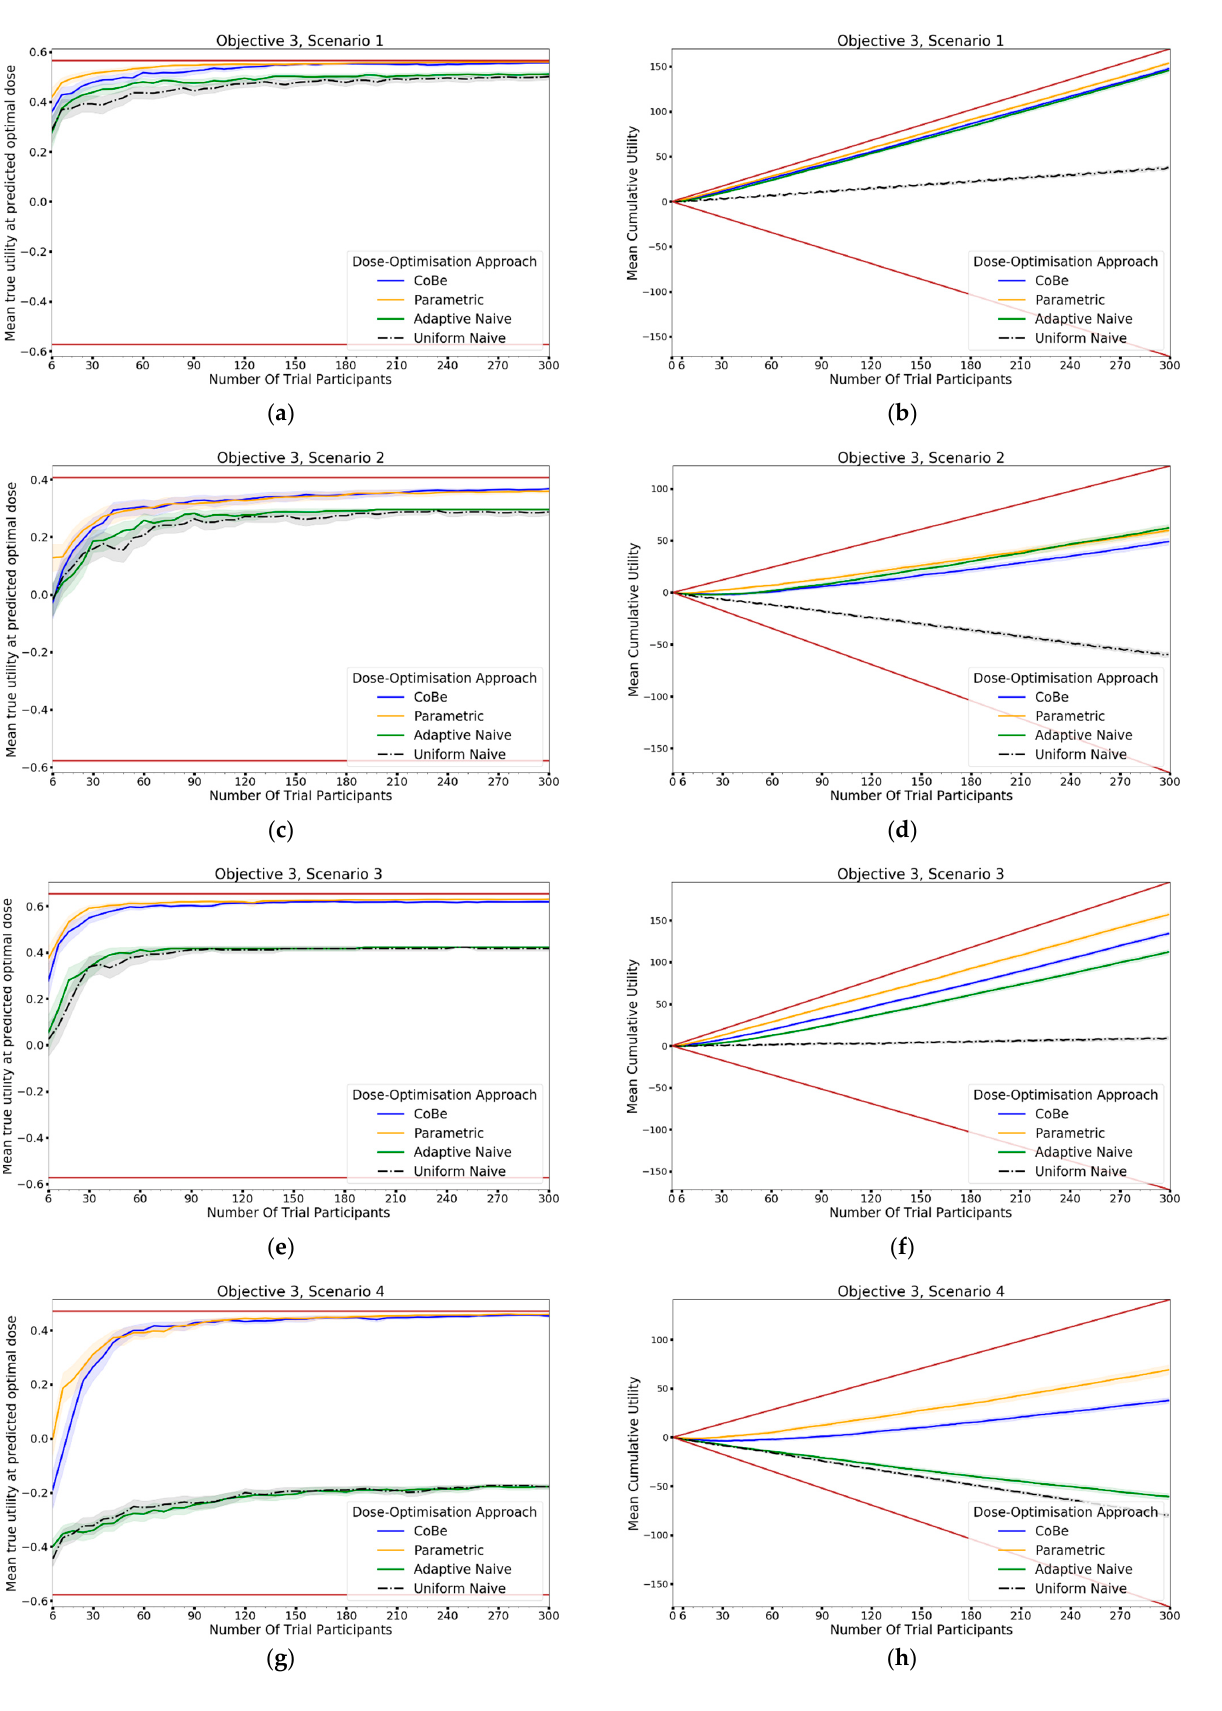
( l ) Figure 12. Mean true utility at the predicted optimal dose (left) and mean cumulative sum of utility (right) against trial size for all six objective 3 scenarios (Scenario 1 ( a , b ), Scenario 2 ( c , d ), Scenario 3 ( e , f ), Scenario 4 ( g , h ), Scenario 5 ( i , j ), Scenario 6 ( k , l )). These are the mean values and 95%CI values across 100 simulations. For the true utility at the predicted optimal dose plots (left), the brown lines show the minimum and maximum possible utility that could be achieved in that scenario. For the cumulative efficacy plots (right) the brown lines represent the maximum and minimum cumulative utility sum that could be expected for that scenario. 3.4. Objective 4. Evaluate the Use of Expert Knowledge Informed Continuous Correlated Beta Process Priors for Vaccine Dose-Optimsation In this objective we assessed how the CoBe DOA that was discussed in objectives 1– 3 would be impacted by the inclusion of expert priors as discussed under the heading of ‘Utilising Expert Knowledge to Inform Continuous Correlated Beta Process Model Priors’ in Section 2.2.1. The black line in Figure 13 (‘No Prior’) reflects the CoBe DOA as it was used in the previous objectives. 3.4.1. True Efficacy/Utility at Predicted Optimal Dose The DOA that best maximised ‘true efficacy at predicted optimal dose’ or ‘true utility at predicted optimal dose’ (from here called ‘true efficacy/utility’) for a given scenario and trial size was considered to be the ‘best’ DOA for the aim of selecting an optimal dose for that scenario. The left-hand side of Figure 13 shows the change in mean true efficacy/util- ity with increasing numbers of trial participants for each of the five DOAs for each sce- nario, averaged across 100 simulated clinical trials. For each of these plots the upper and lower brown lines, respectively, show the maximal and minimal efficacy/utility possible for that scenario. A mean true efficacy/utility for a DOA being closer to the upper brown